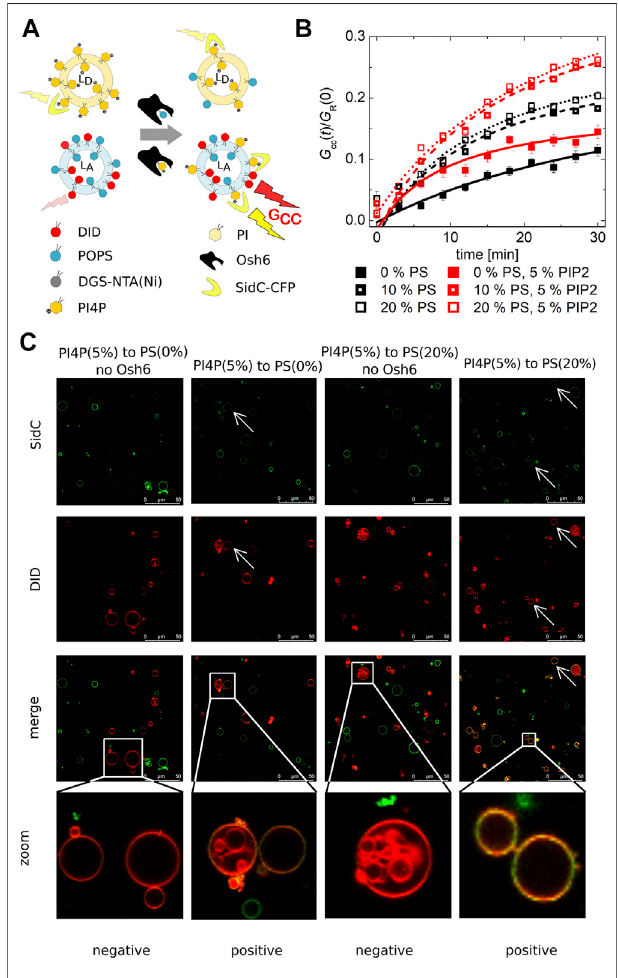
FIGURE 2 | PI4P transport observed by the FCCS assay. (A) Schematics of the FCCS assay. (B) Temporal evolution of the transport- monitoring parameter G cc / G R . PI4P was transported to the LUVs with an increasing amount of PS: POPC only (full squares), 10 mol% of PS (half- fi lled squares), and 20 mol% of PS (empty squares). The PI4P-donating membrane (5 mol% PI4P) was also enriched in PIP2 (5 mol%): wo/w PIP2 — black/red squares. The error bars stand for the standard deviation. (C) Reconstitution of the PI4P transport to the membranes of GUVs. Red GUVs are PI4P-accepting GUVs, and the presence of the green PI4P biosensor on theredGUVsrefersonthetransport.Thepresenteddatarepresentthetrends that were observed in minimum three independent